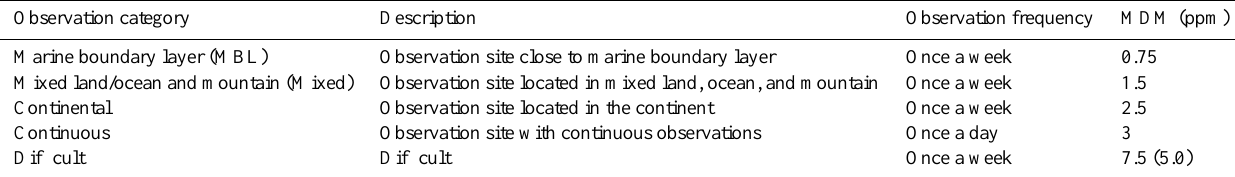
Table 2. Observation site categories and corresponding MDM